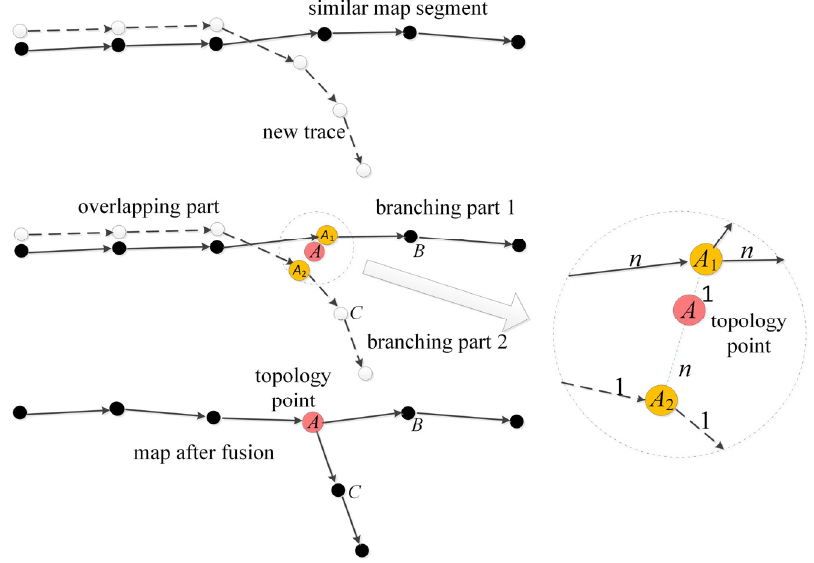
Figure 4. Topology point extraction from trace data.